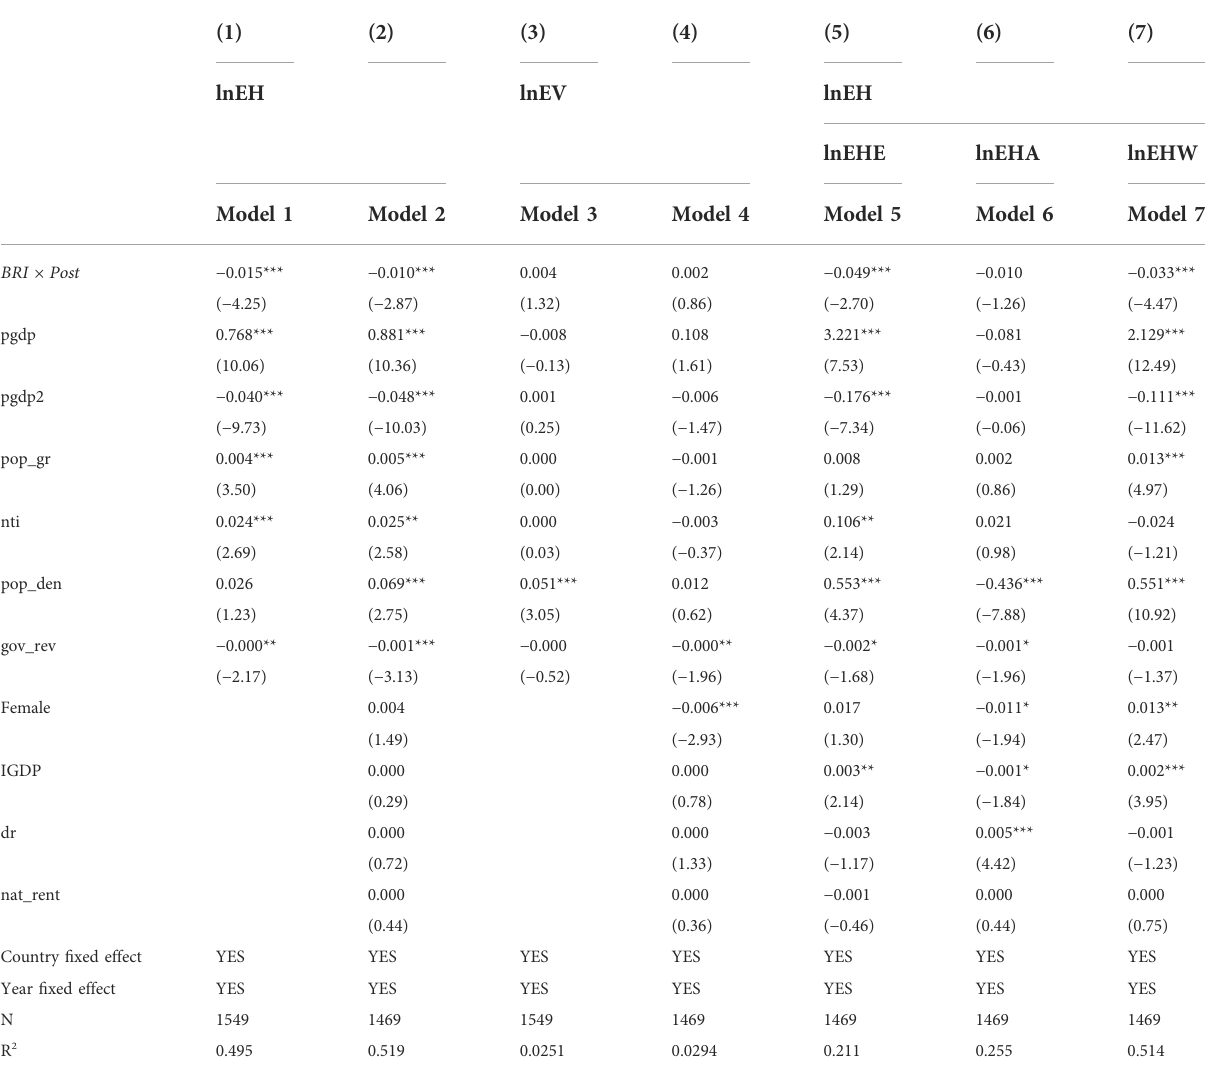
TABLE 8 Effects of the Belt and Road Initiative on environmental quality: Sub-indicators of